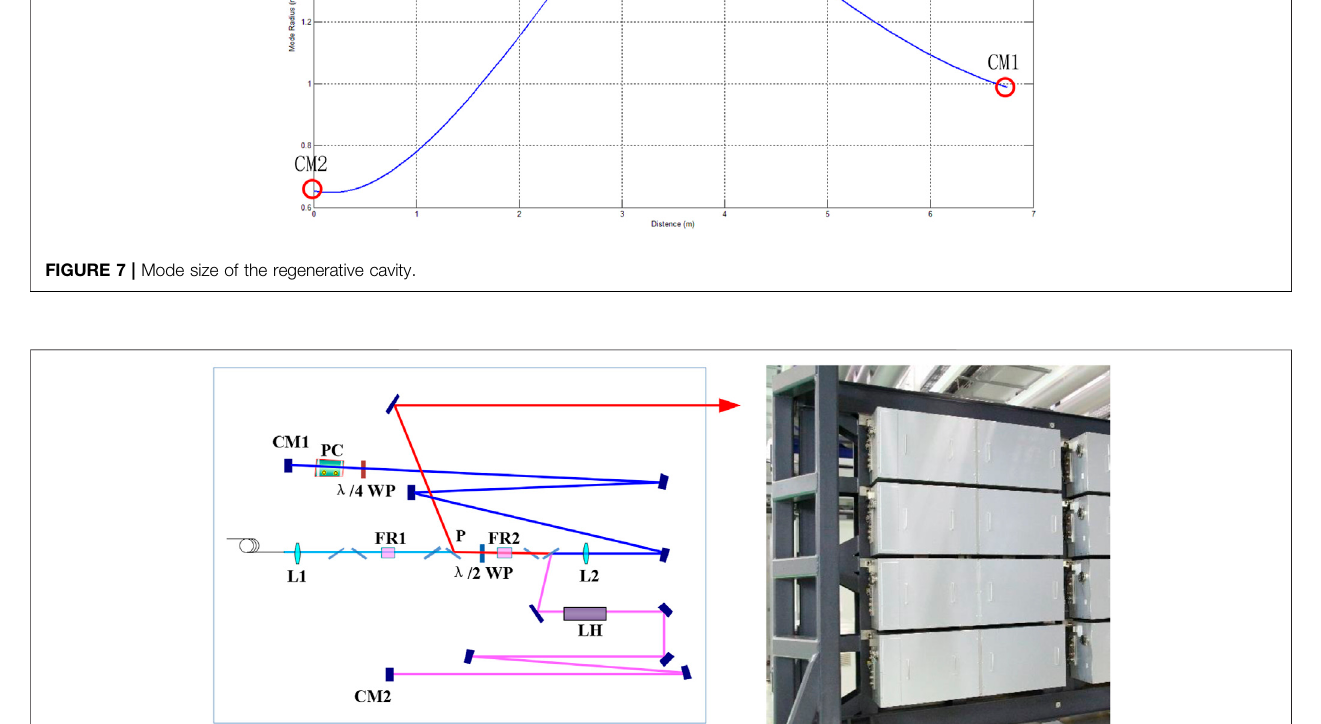
FIGURE 8 | Schematic diagram of the regenerative ampli fi er.